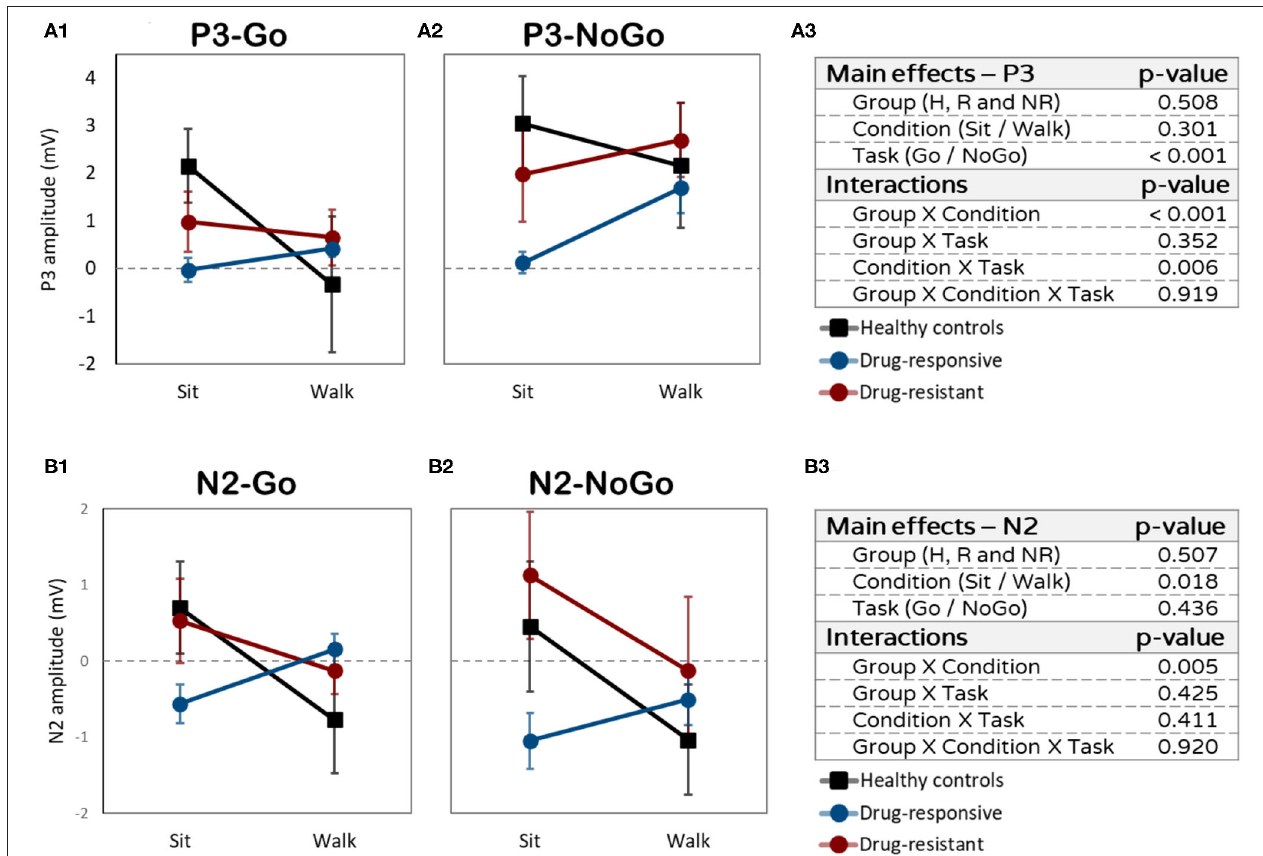
FIGURE 3 | Amplitudes differences (in mV) between sitting and walking. (A1) P3 amplitudes while performing the Go task. (A2) P3 mplitudes while performing the NoGo task. (A3) P3 effects and interactions summery. (B1) N2 amplitudes while performing the Go task. (B2) N2 amplitudes while performing the NoGo task. (B3) N2 effects and interactions